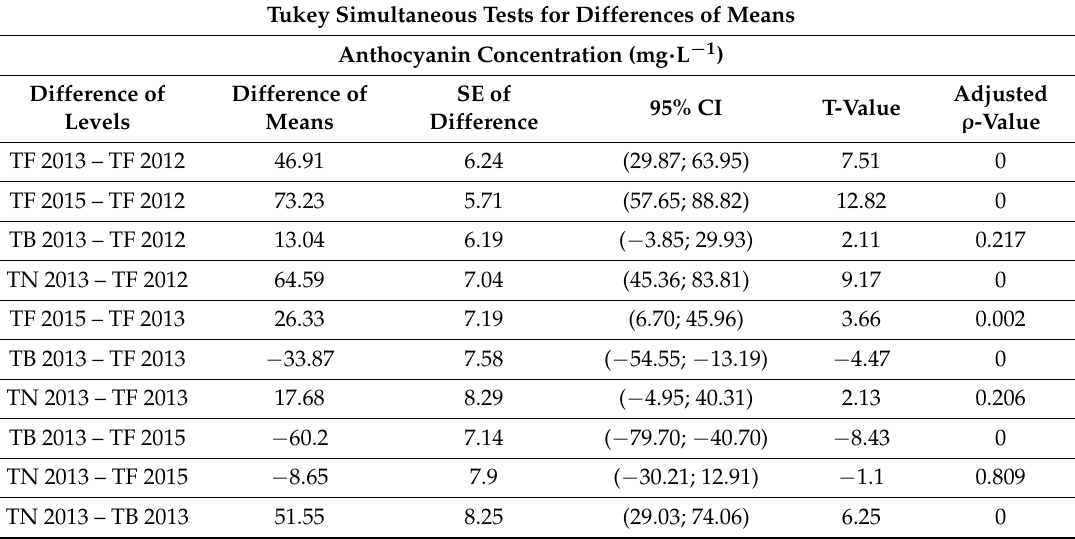
Table A4. One-way ANOVA for the anthocyanin concentration of the laboratory results. Tukey Simultaneous Tests for Differences of